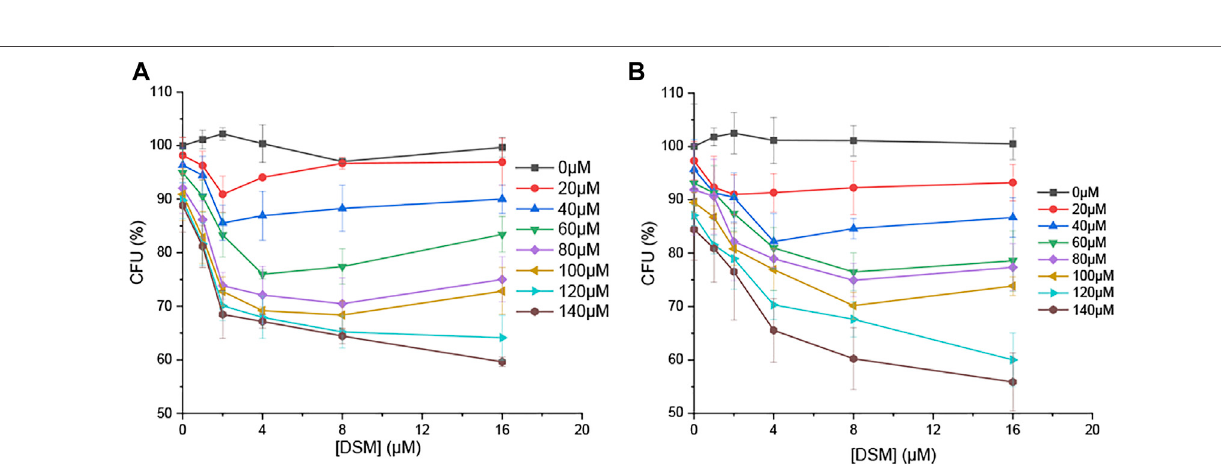
Frontiers in Chemistry |